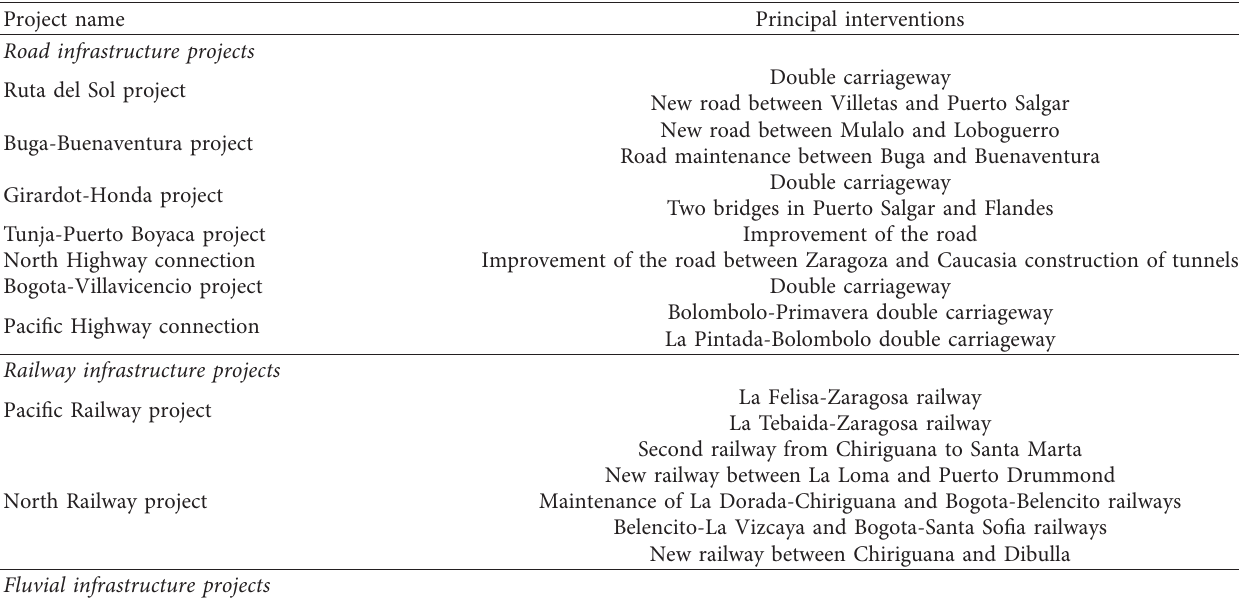
Table 2: Temperature and wildlife count in the three areas covered by the